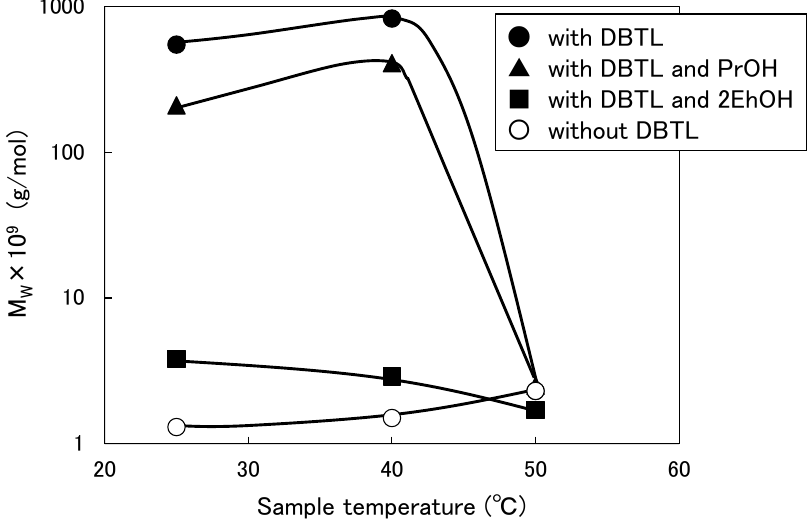
Figure 6. Relationship between the sample temperature and weight-average molecular weight (M W ) and the effects of additional organic solvent on M W .